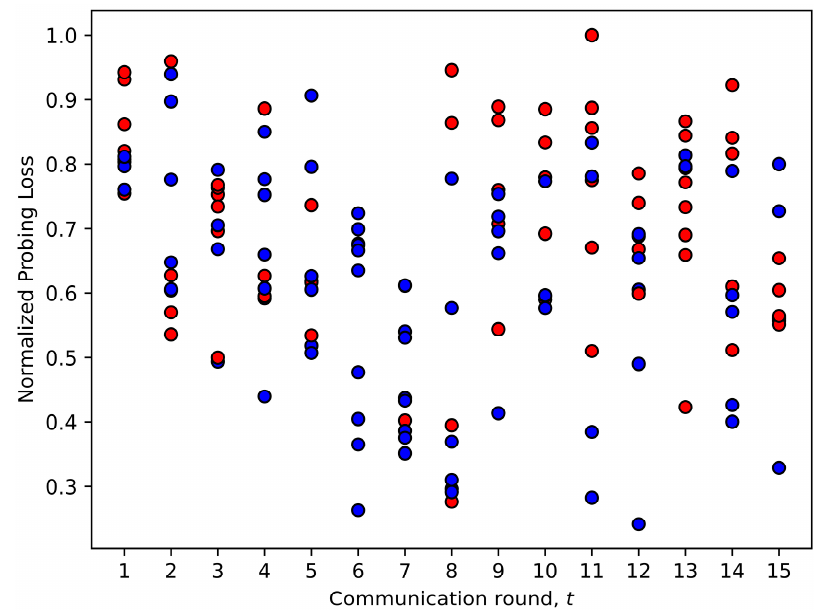
Figure 10. Decisions made by FedDdrl based on probing loss.